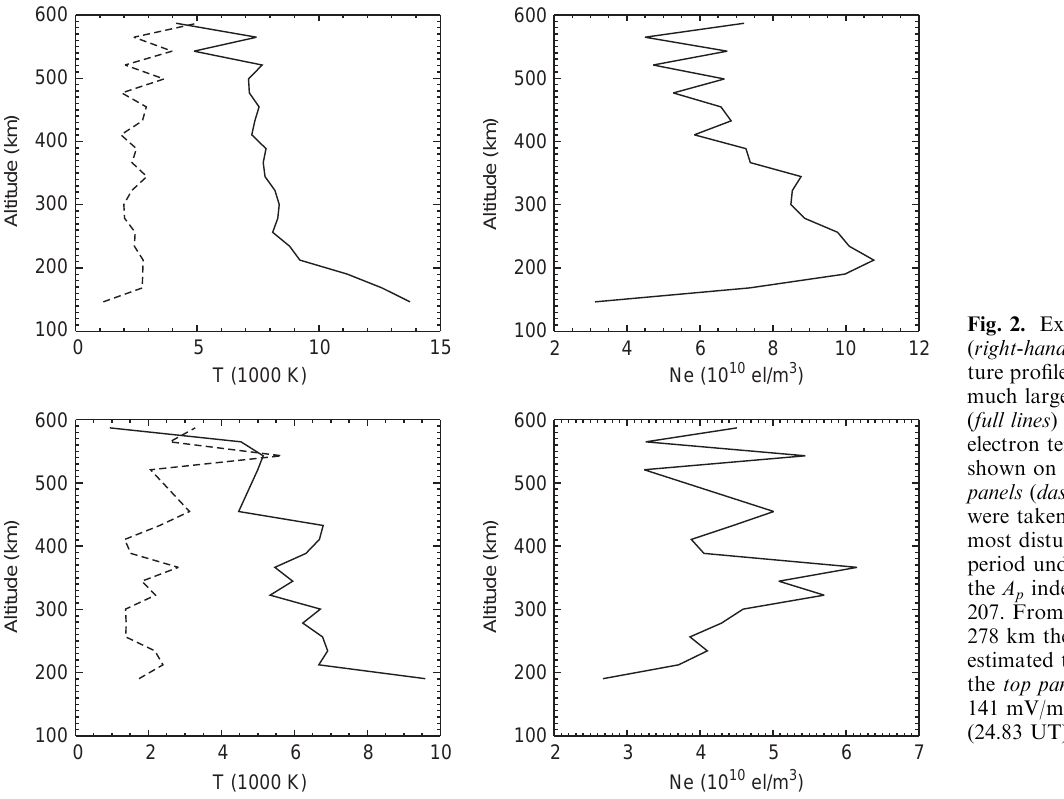
Fig. 2. Example of density ( right-hand-side ) and tempera- ture profiles ( left-hand-side ) with much larger ion temperatures ( full lines ) than average. The electron temperatures are also shown on the left-hand-side panels ( dashed lines ). The times were taken in the middle of the most disturbed interval for the period under study, taken when the A p index reached a value of 207. From the ion drift at 278 km the electric field was estimated to be 225 mV/m for the top panels (24.25 UT) and 141 mV/m for the bottom panels